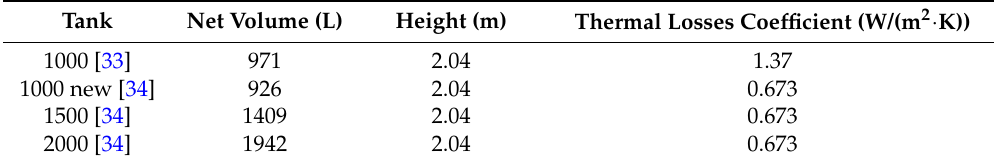
Table 10. Main characteristics of the considered hot water